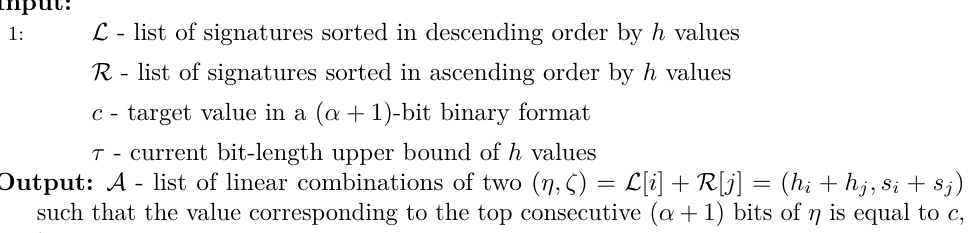
Algorithm 4 Collecting linear combinations of two